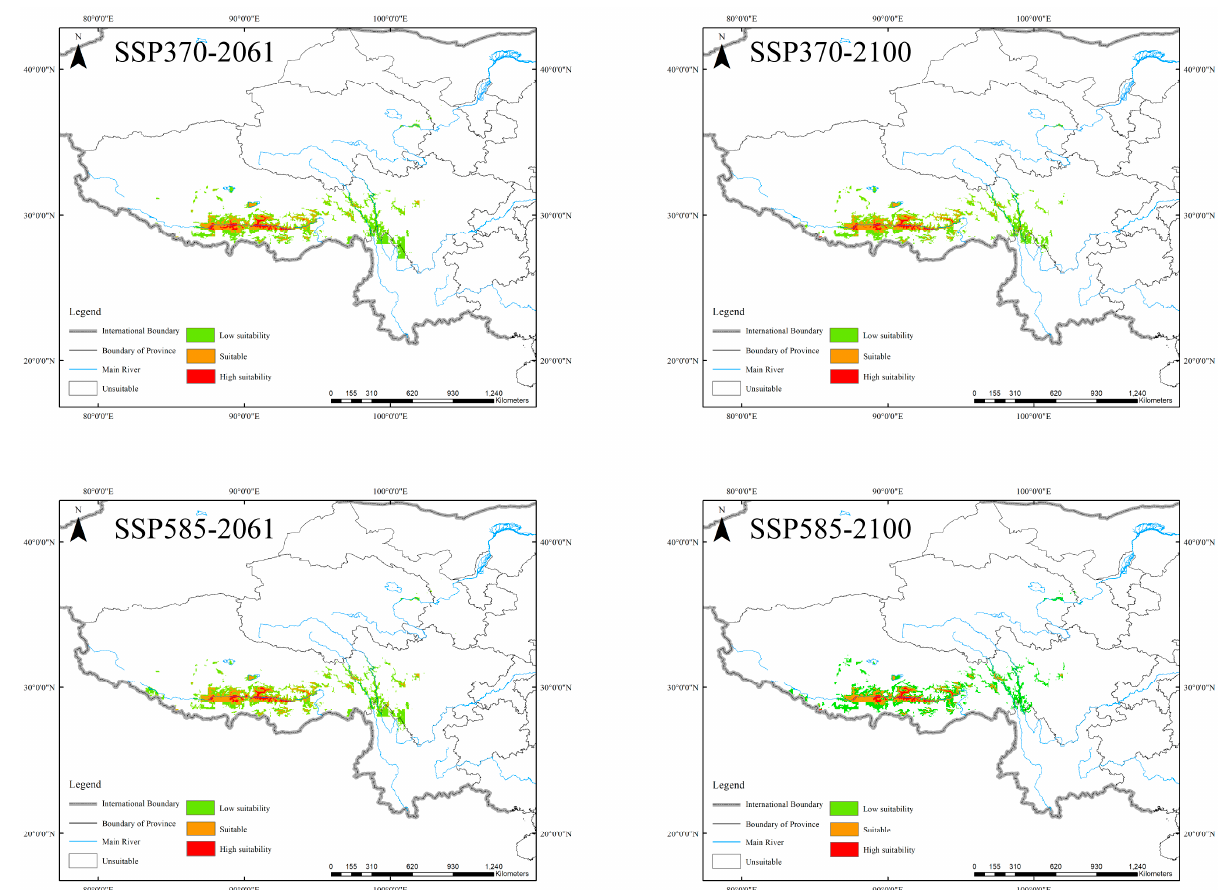
Figure 3. Projected future habitat distribution of S. moorcroftiana from 2020 to 2100 under four future climate scenarios (SSP126, SSP245, SSP370, and SSP585).